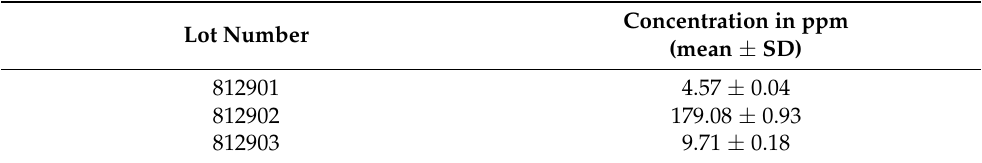
Table 2. Quantified amount of enrofloxacin in different lot numbers of the NPJ.